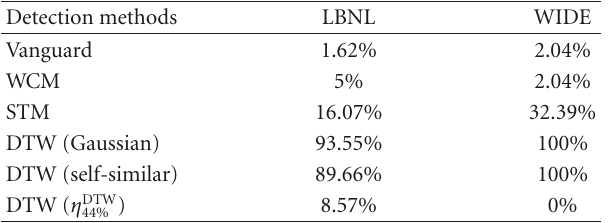
Table 1: A comparison of the detection methods’ false positive rates.